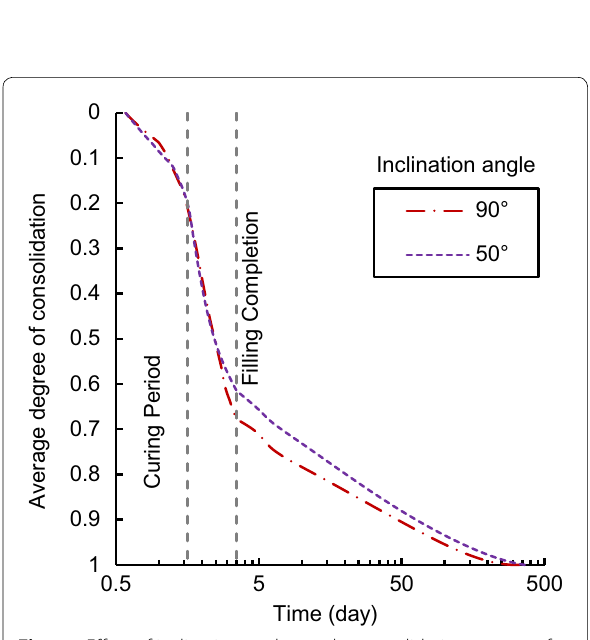
Fig. 15 Effect of inclination angles on the consolidation process of